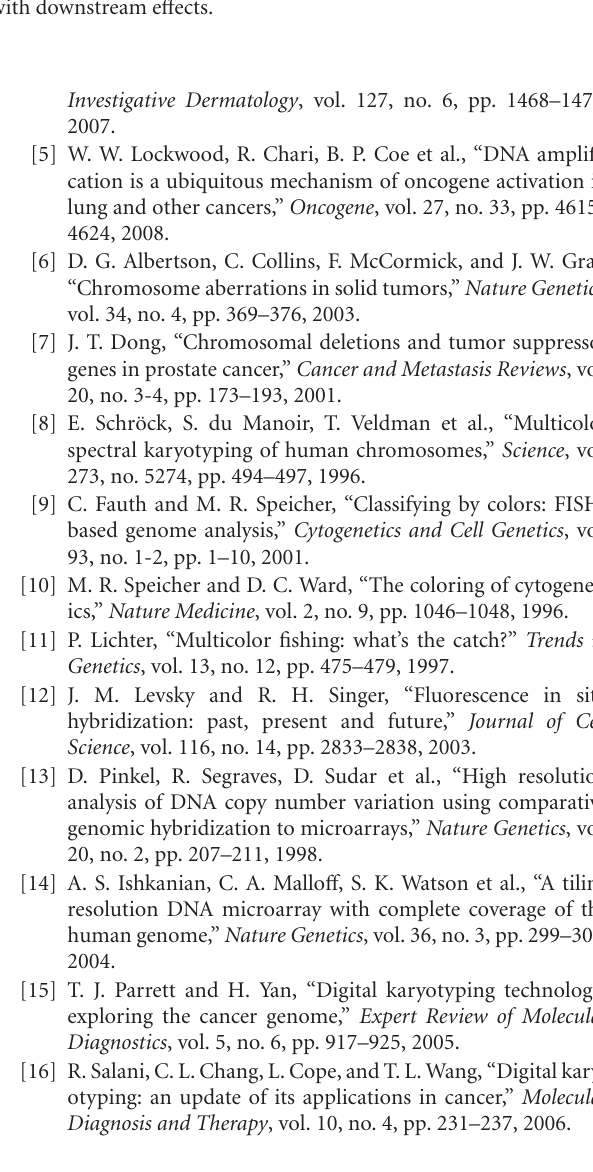
Figure 7: The integrated network of genome-wide analyses comprising the cancer omics landscape. Phenomics or phenotypic e ff ects are the direct consequence of the perturbations of genes and pathways which could be traced to genetic and epigenetic alterations when multiple dimensions of information are integrated to connect upstream causes with downstream e ff